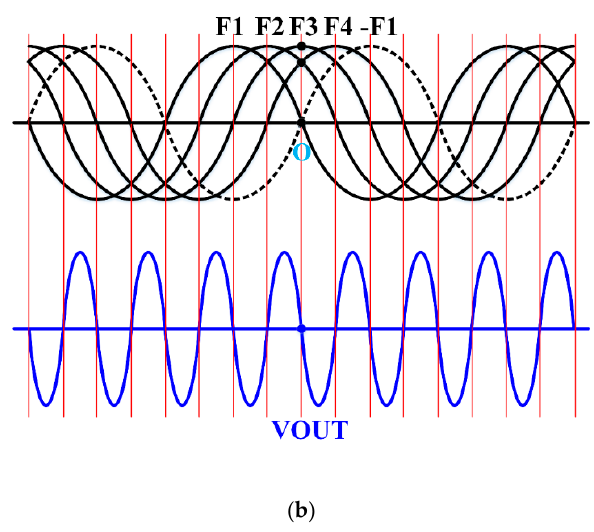
Figure 5. ( a ) The folding amplifier in the second stage; ( b ) The input and output signals.